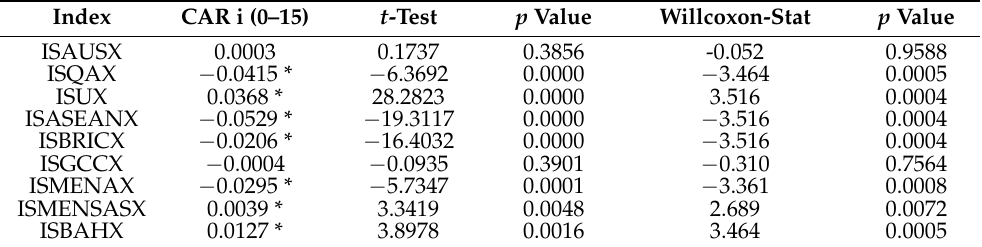
Table 4. Cumulative abnormal return (CAR) in short-term window.